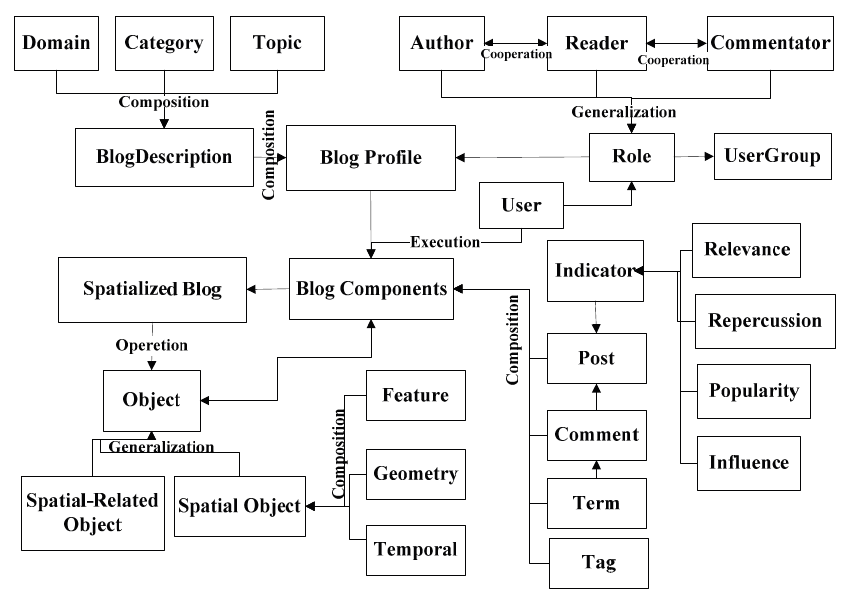
Figure 2. The conceptual model of